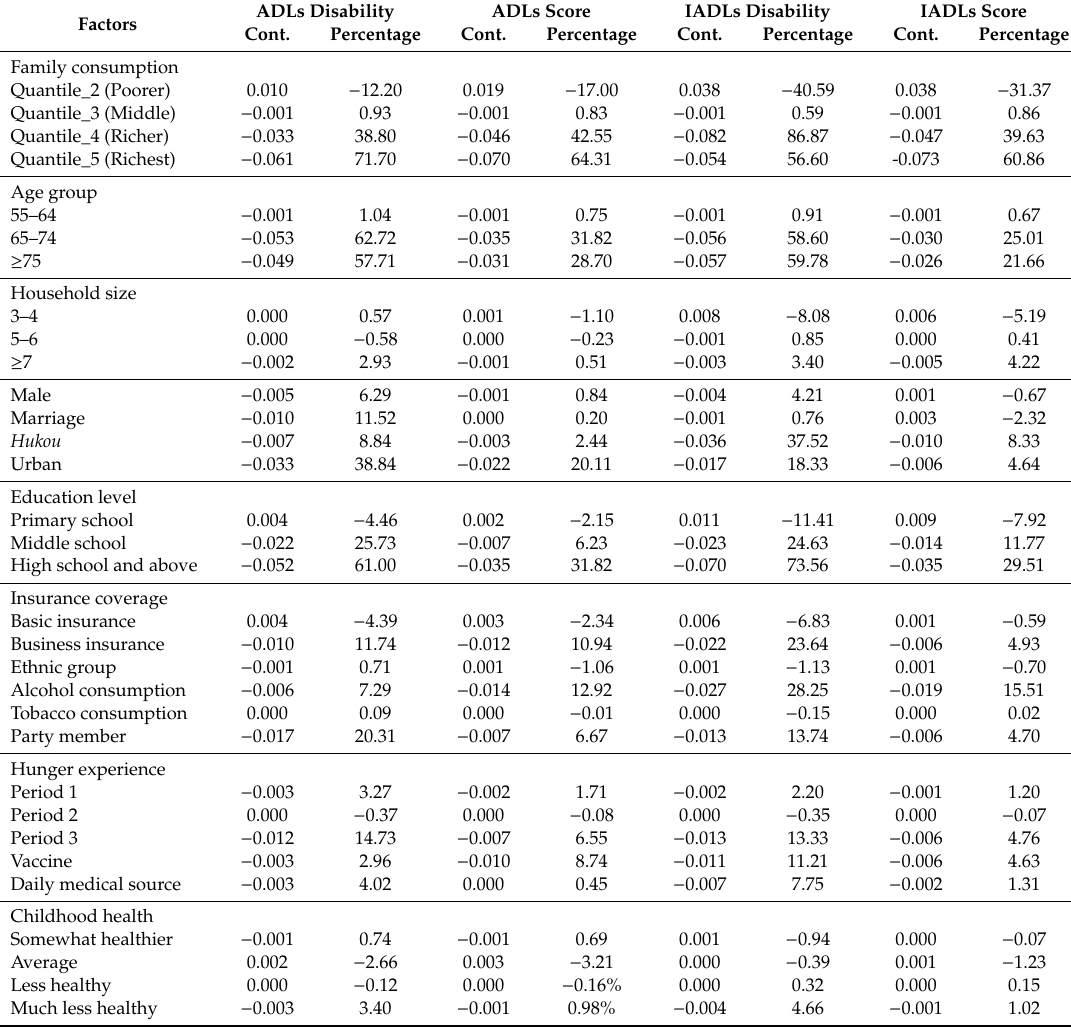
Table 4. Decomposition of inequalities in long-term care need among older adults with chronic disease. ADLs Disability ADLs Score IADLs Disability IADLs Score Factors Cont. Percentage Cont. Percentage Cont. Percentage Cont. Percentage